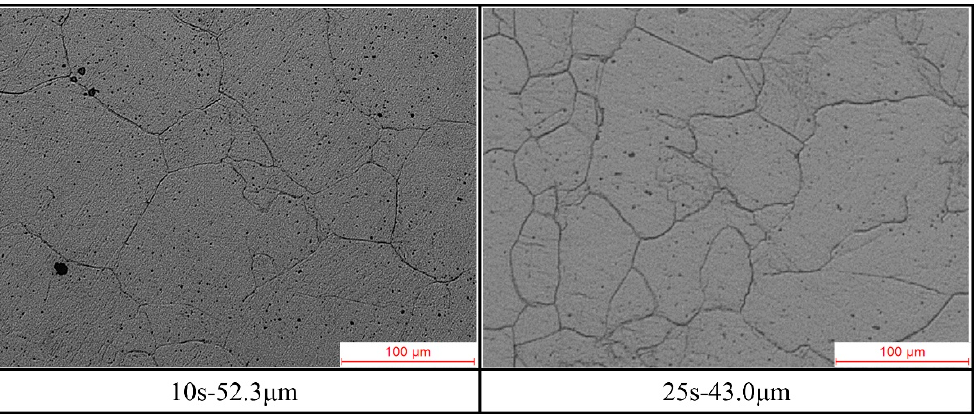
Figure 7. Evolution of the austenite grain with mean grain sizes in Ti microalloyed steel deformed at 960 °C and held for different times.